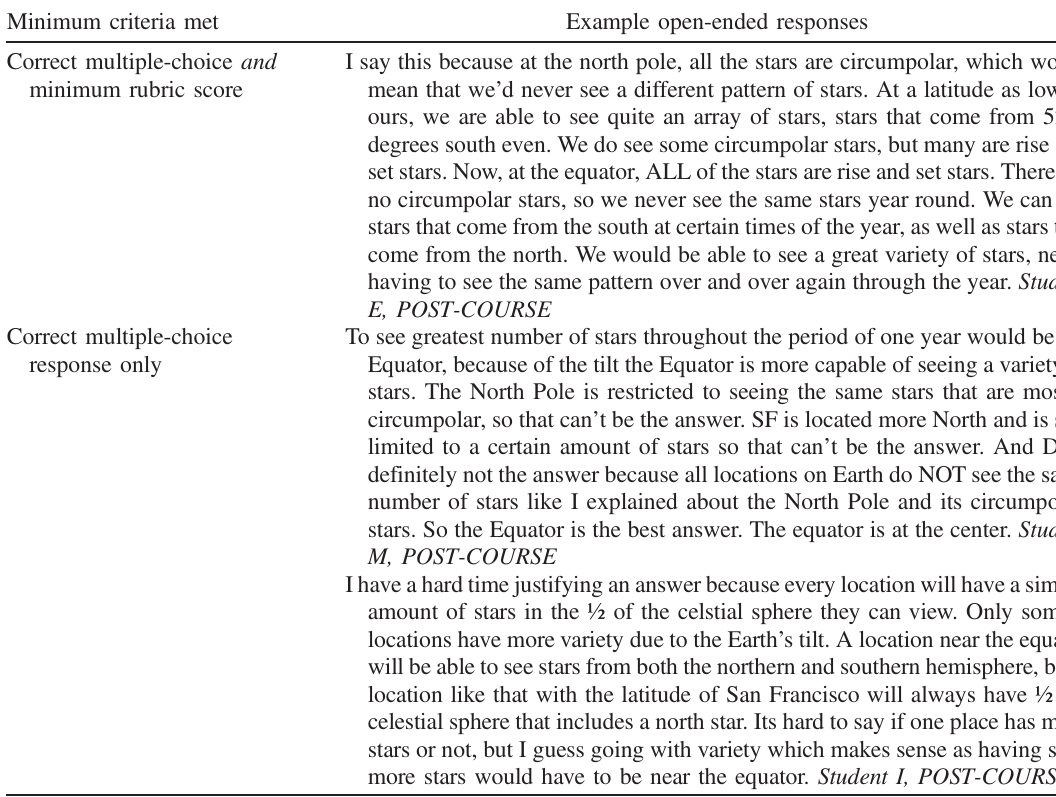
TABLE V. Example open-ended responses given for the assessment about the portion of the celestial sphere visible from different